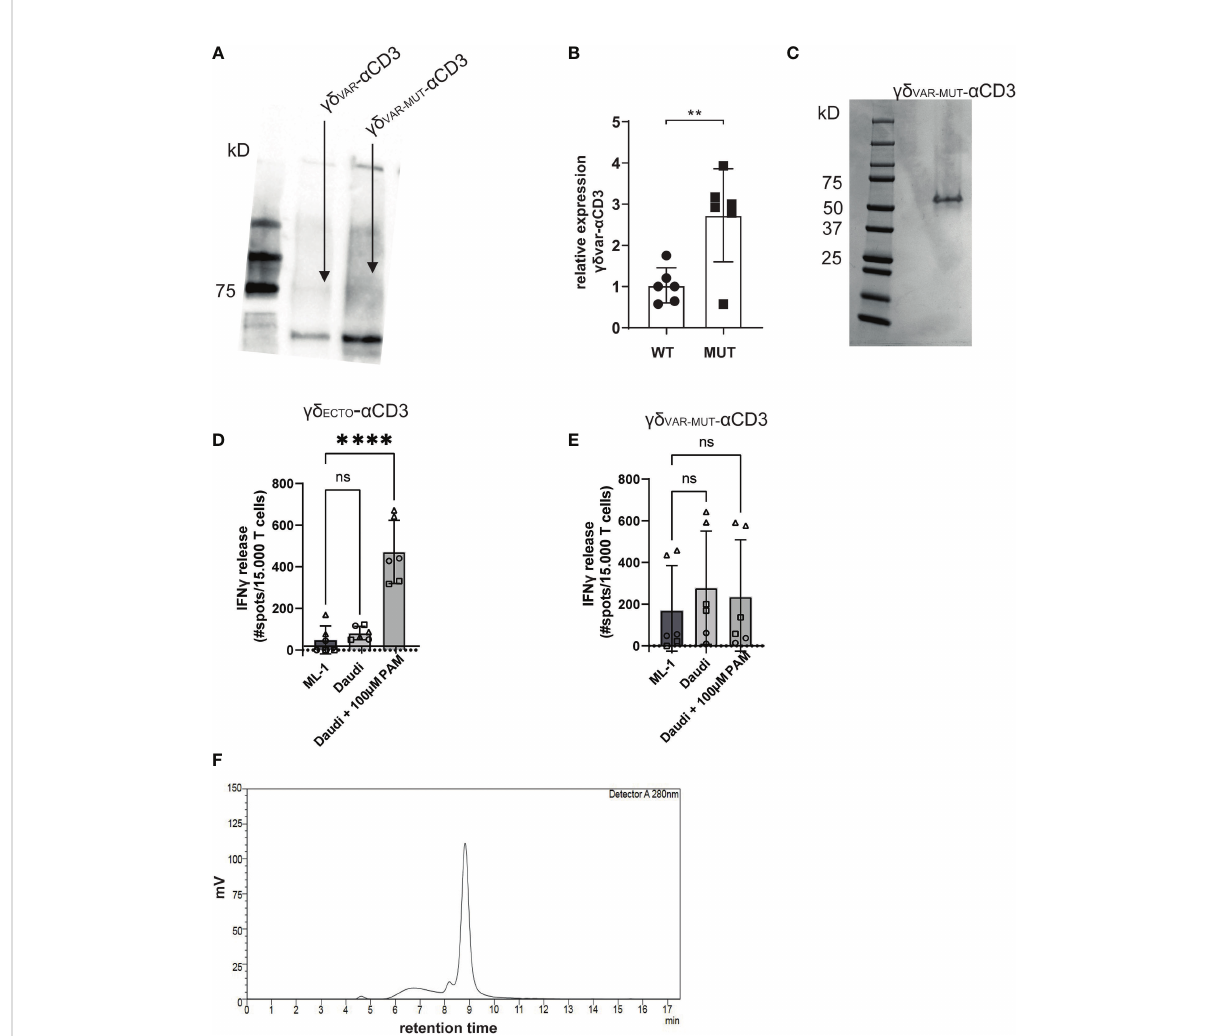
FIGURE 2 gd VAR-MUT – a CD3 does not redirect T cells to tumor cells (A) gd Var – a CD3 WT or with six stabilizing mutations, were expressed in HEK293F cells, and protein expression was visualized using His-Tag western blot. (B) Expression of gd Var – a CD3 6mut relative to the WT gd Var – a CD3. N=6 error bars represent SD, signi fi cance was calculated using an unpaired **p ≤ 0.01. (C) SDS-PAGE analysis of puri fi ed gd VAR-MUT – a CD3. D\E) T lymphocytes were co-incubated with (D) gd ECTO - a CD3 or (E) gd VAR-MUT – a CD3 (5-10 µg/ml) and target cells ML-1 or Daudi, -/+ 100 µM pamidronate (PAM). IFN g release was measured by ELISPOT. The different symbols represent three different experiments (two technical replicates). N=3, error bars represent SEM, signi fi cance was calculated using one-way ANOVA, ns not signi fi cant p>0.05, ****p ≤ 0.0001. (F) Size exclusion chromatogram of the gd VAR-MUT – a